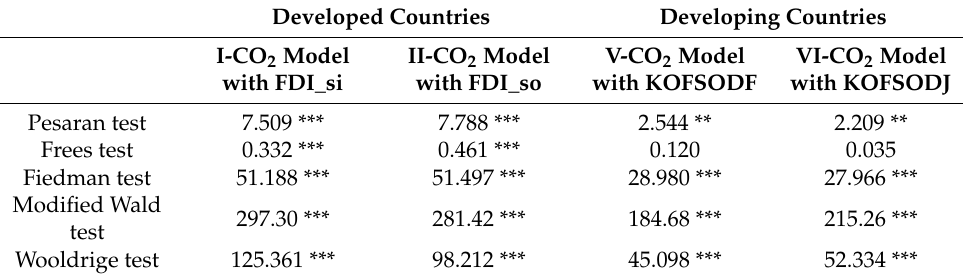
Table A2. Specification tests for CO 2 model (2000–2017).